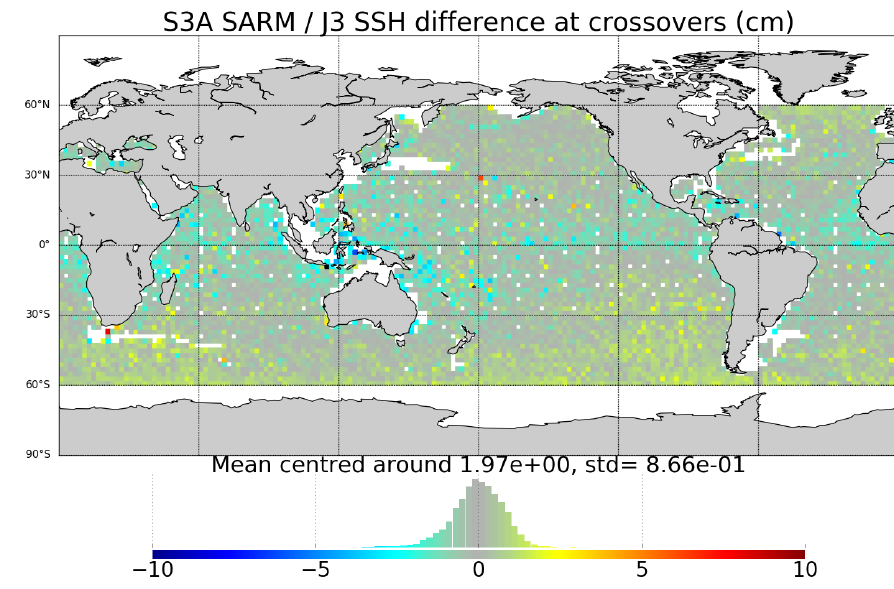
Figure 29. Map of mean Sea Surface Height difference at Sentinel-3A SARM/Jason-3 crossovers, computed from April 2016 to September 2019, using Sentinel-3A 2020 reprocessed dataset. The mean bias of 1.97 cm has been removed before